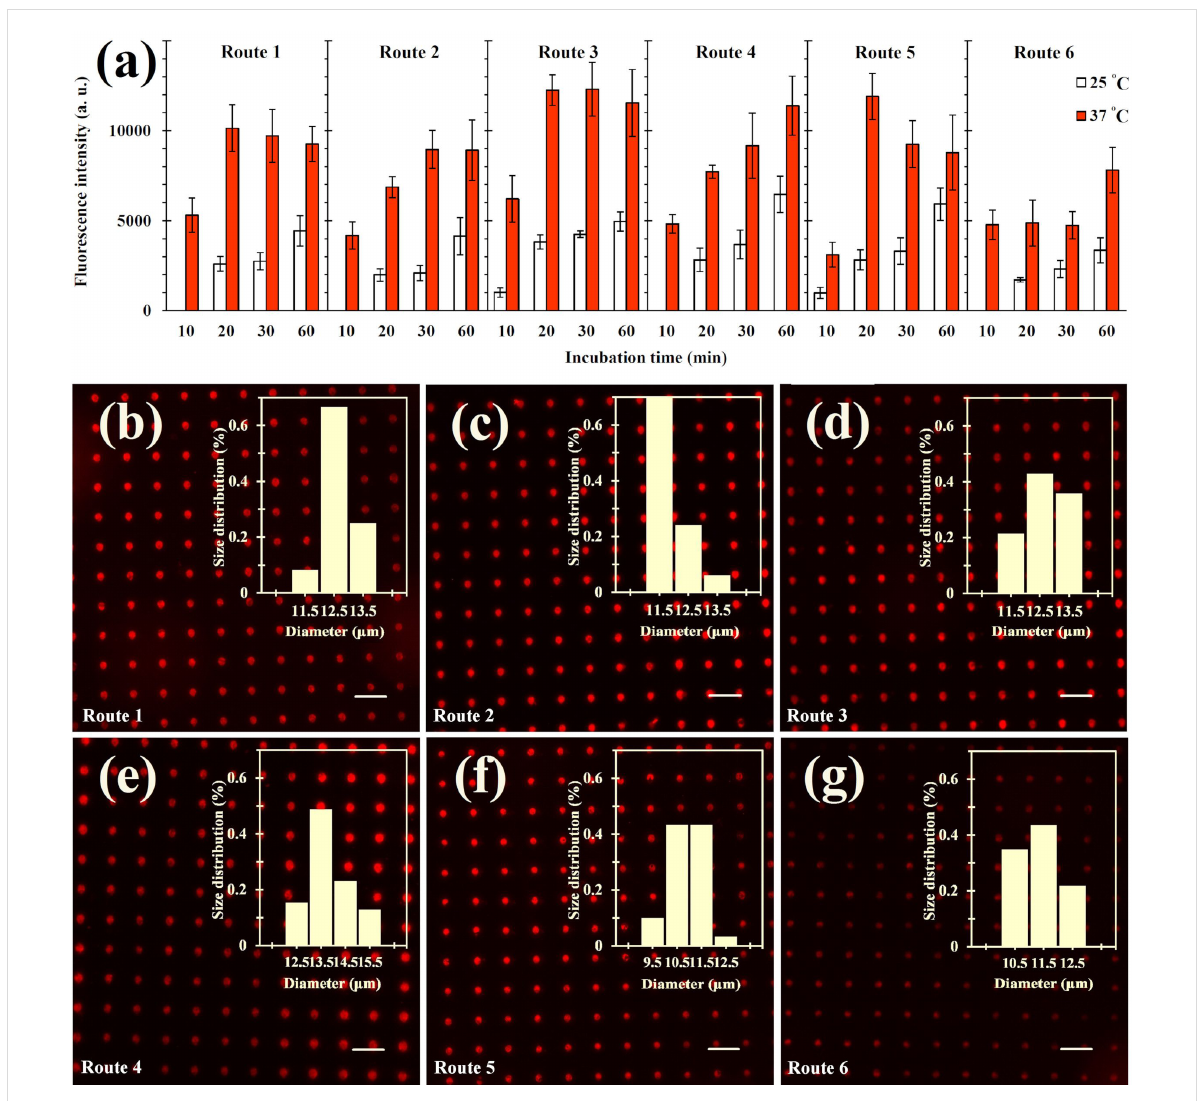
Figure 4: Detection of the AFP antigen. a) Fluorescence of the microarrays after incubating fluorescently labeled AFP spots with anti-AFP on the sur- faces at different times (10, 20, 30 and 60 min) and at two temperatures (25 and 37 °C). Anti-AFP was immobilized on the different biotinylated sur- faces using the biotin–streptavidin–biotin sandwich technique previously prepared via different click reaction methods (samples of routes 1–6). b–g) Fluorescence microscope images of the micropatterns obtained at the optimum incubation time and temperature. All microarrays were spotted at a relative humidity of 20%. The ink concentration was 800 μ g/mL. Dwell and exposure times of all images were 0.1 and 0.4 s, respectively. The corre- sponding spot size distribution is given in the insets. All scale bars are equal to 50 μ